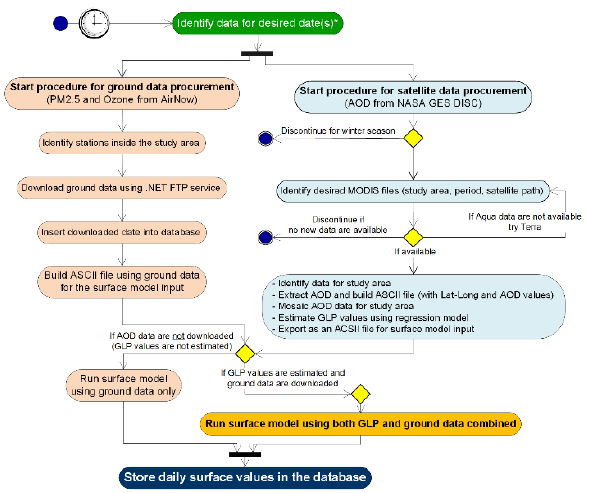
Figure 2. Process diagram for daily geospatial surface modelling for ground level PM2.5 (GPL) and ozone for